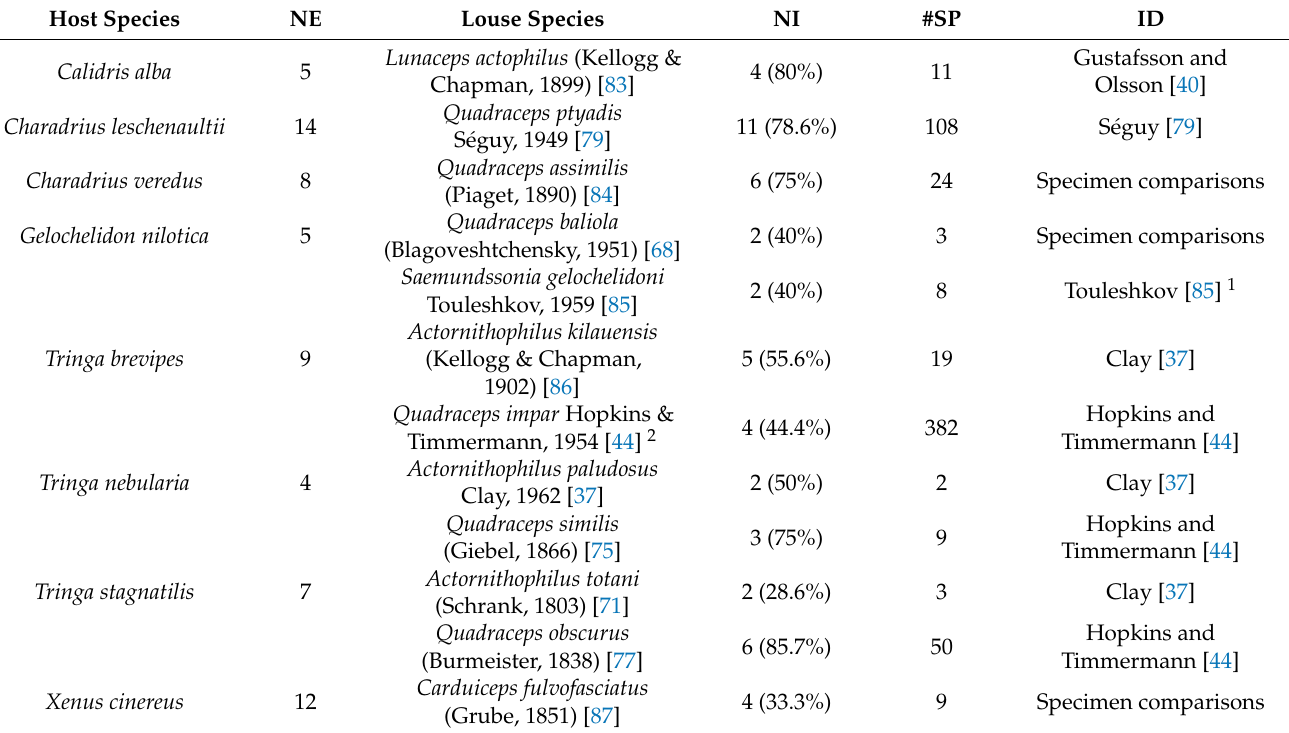
Table 4. New records of chewing lice for Australia. As these specimens are not accessible to us during the current period of restricted travel from China, only overall prevalence and the total number of louse specimens collected from that host are given. Abbreviations used: ID = resources used for identification of lice; NE = number of hosts examined; NI (P) = number of hosts infested (prevalence); #SP = total number of specimens collected.